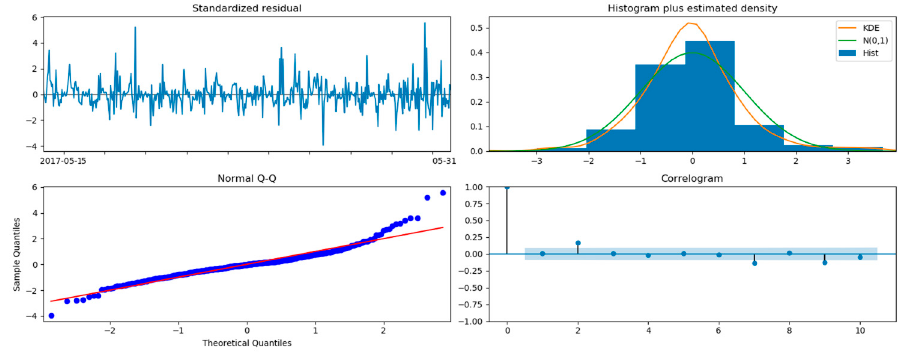
measurements. IBIS measurements.